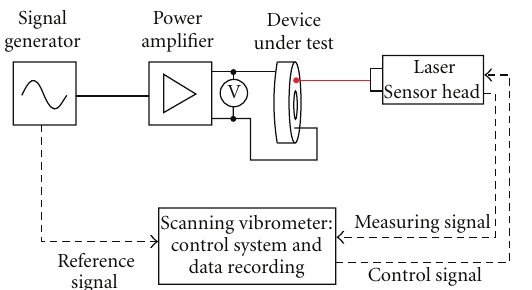
Figure 5: Displacement measurement of one piezoelectric ring.